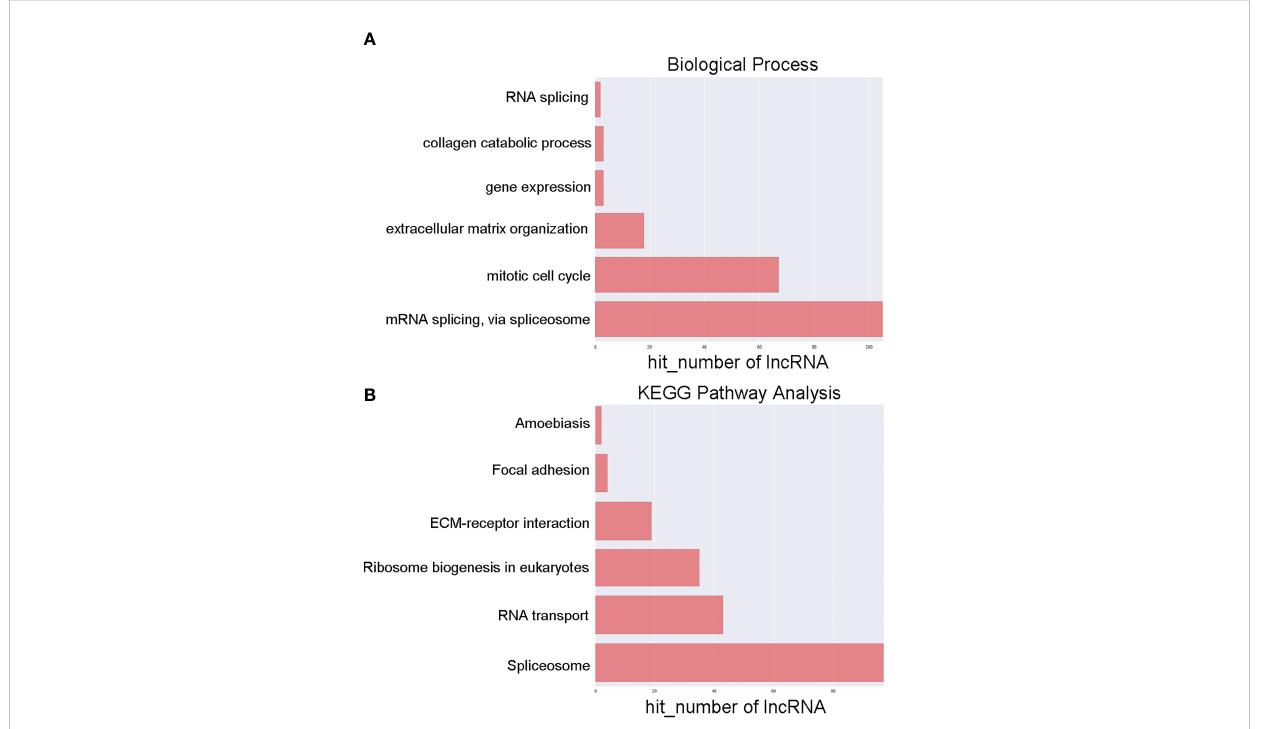
FIGURE 2 GO and KEGG pathway analyses of lncRNAs differentially expressed between early-stage and locally advanced GC. (A) The top 6 biological process GO terms corresponding to dysregulated lncRNAs. (B) The top 6 KEGG terms corresponding to dysregulated lncRNAs. Annotated terms and numbers of genes associated with those terms are respectively shown on the y-axis and the